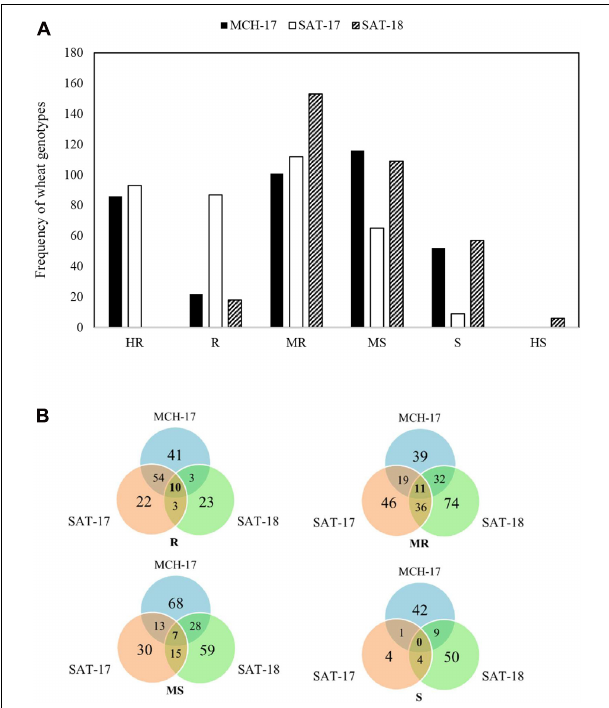
FIGURE 2 | Frequency distribution of area under the disease progress curve (AUDPC) of Septoria tritici blotch in Sidi Allal Tazi during 2017 (SAT-17), 2018 (SAT-18), and in Marchouch during 2017 (MCH-17) in Morocco (A) . Venn diagram of field responses of 377 ABLs to Septoria tritici blotch in Sidi Allal Tazi and Marchouch in Morocco (B) . Here HR, R, MR, MS, S, and HS represent highly resistant, resistant, moderately resistant, moderately susceptible, susceptible, and highly susceptible, respectively.